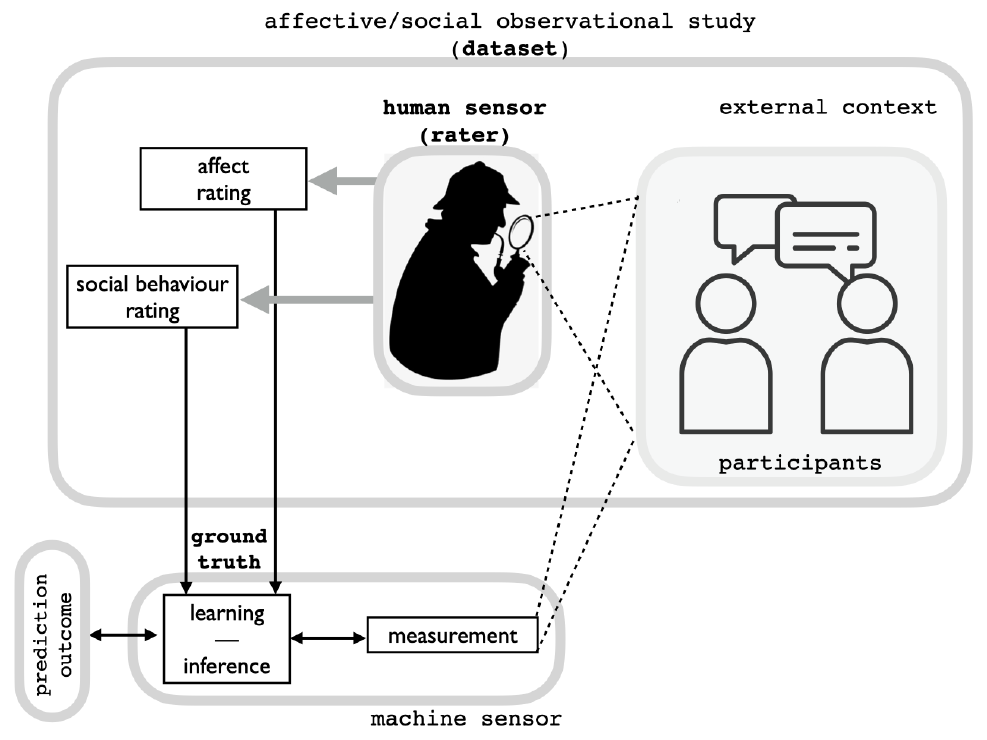
Figure 1. A standard scenario for dataset construction and exploitation. Multimodal data are collected from the behaviour of participants involved in some affective/social task or context (for simplicity, the recording apparatus is not explicitly shown in the scheme). A “ground truth” is provided by the rater sensing affect/social behaviour unfolding (e.g., in terms of valence and arousal dimensions). Data and ground truths are subsequently exploited for computational model training and testing to obtain prediction outcomes of interest (e.g., classification of affective/social behaviour